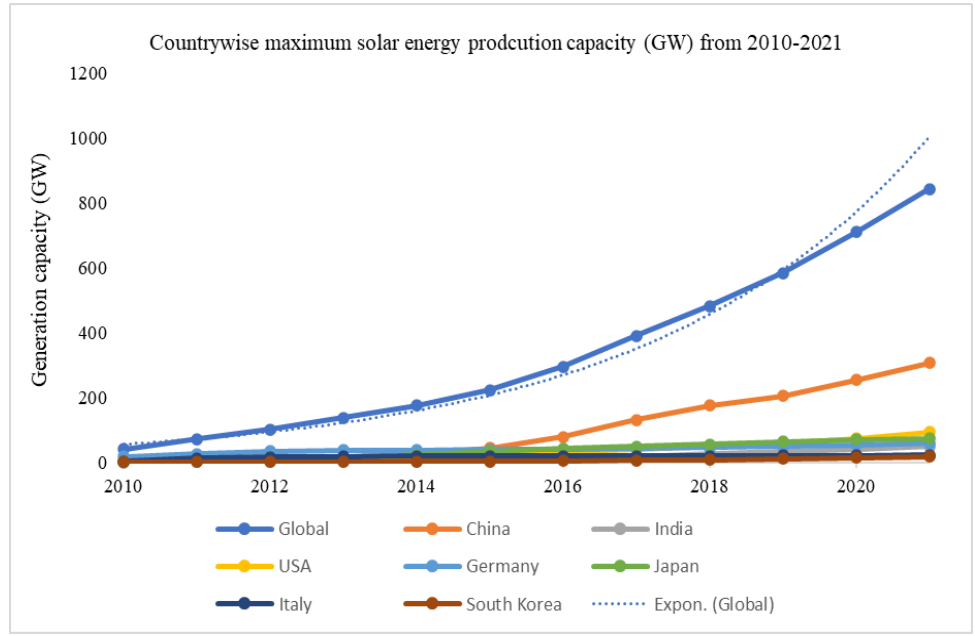
Figure 1. Global solar production for the top seven countries